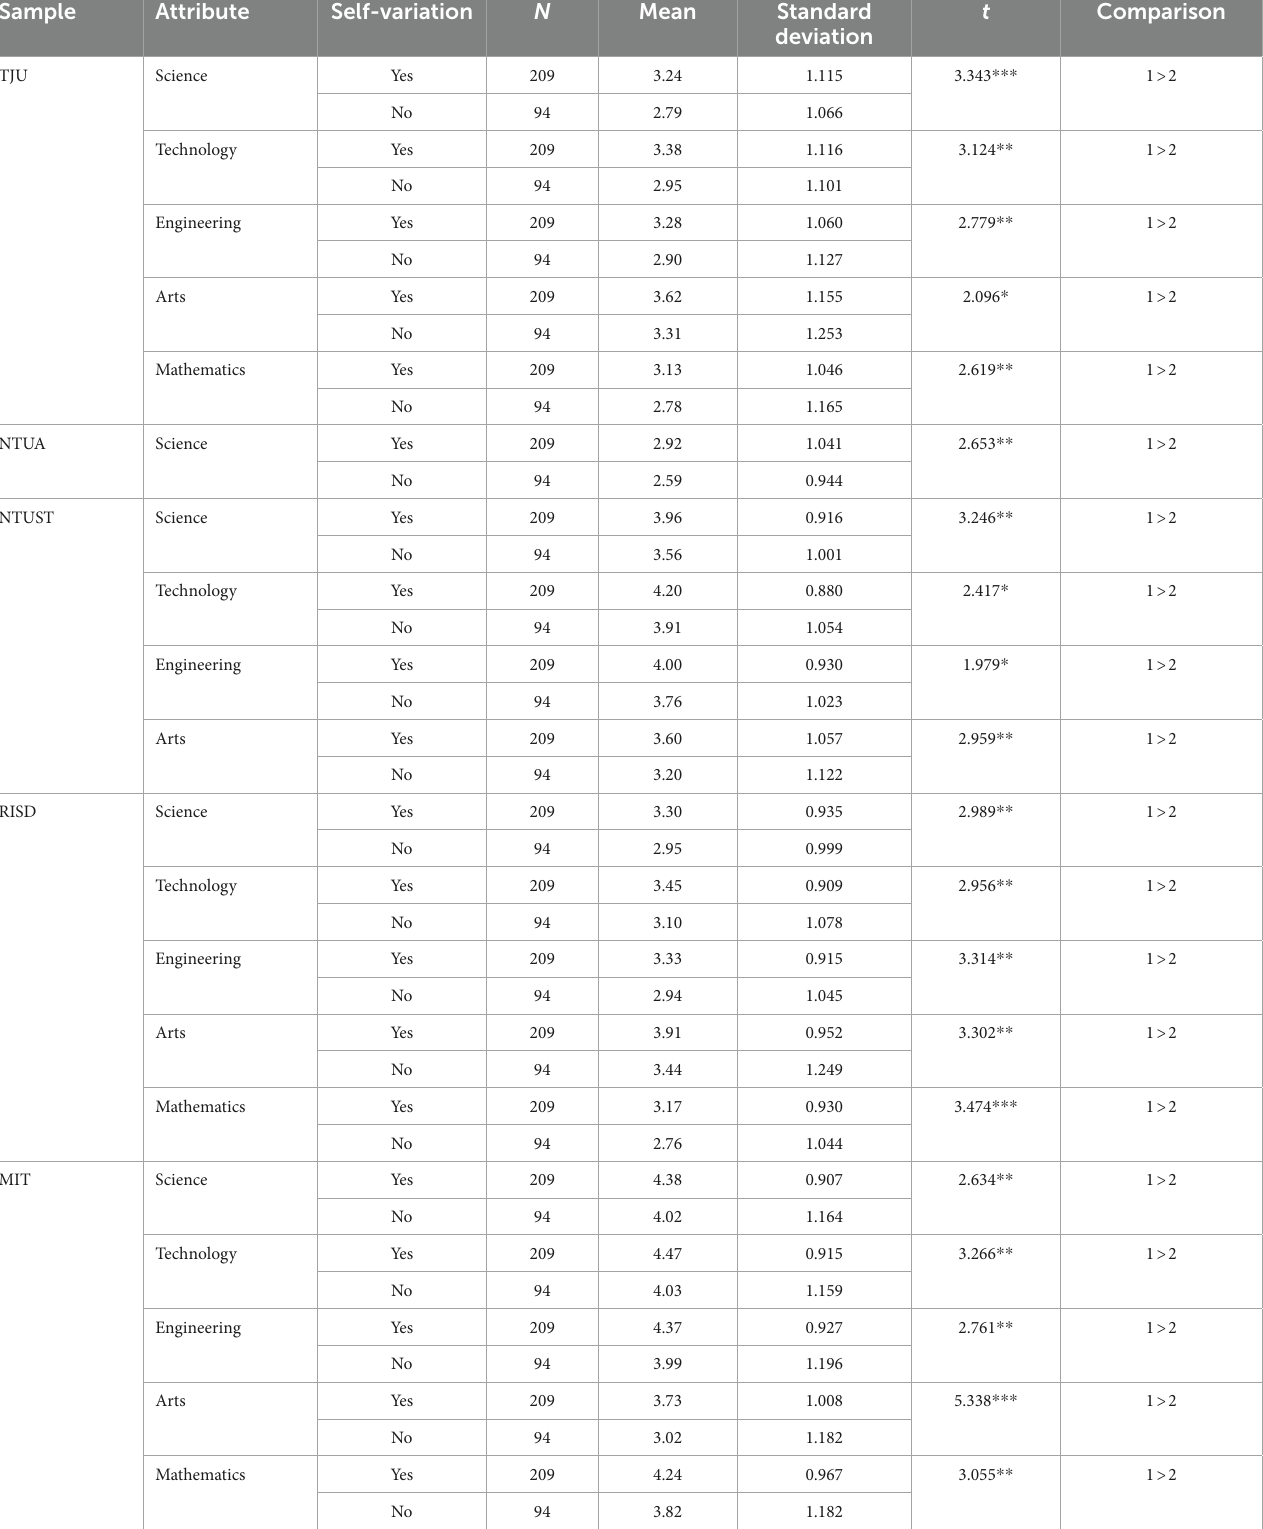
TABLE 6 Cognitive differences between subjects who were familiar or unfamiliar with STEAM.